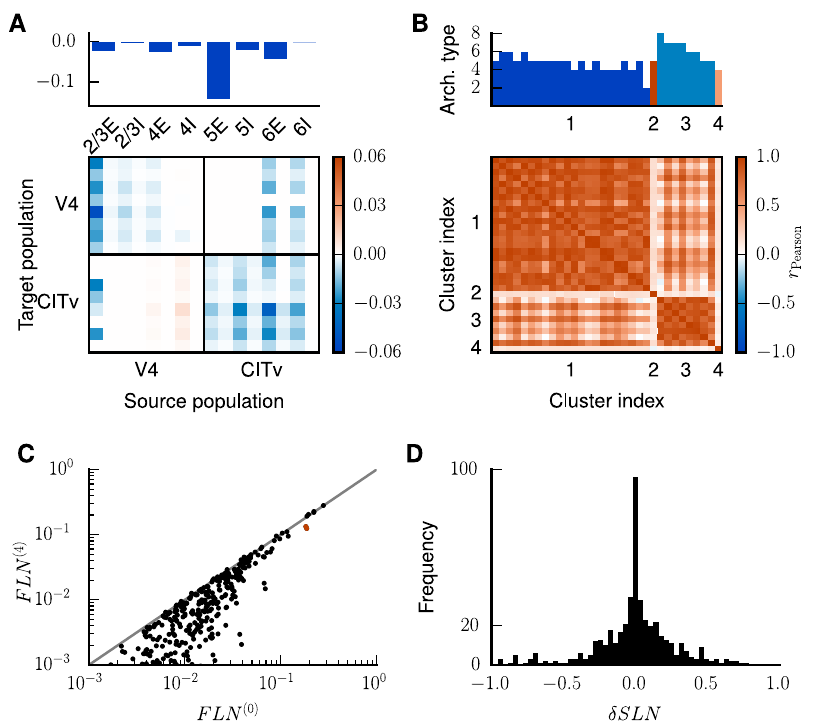
Fig 8. Analysis of changes in connectivity. A Top panel: relative changesin population-specific intrinsic P P d K ij = K ij i indegreessummed over target populations and averaged across areas, h . Bottom panel: A AA AA i i changesin the indegreeswithin and betweenexemplary areas V4 and CITv relative to the total indegreesof P = K ij the target populations,i.e., d K ij . Populationsorderedas in Fig 7C. B Pearson correlationcoefficient AA AA j of the changes of the internalindegrees d K ij between all pairs of the 32 areas. Areas ordered accordingto AA hierarchical clustering using a farthest point algorithm[31]. The heights of the bars on top of the matrix indicatethe architectural types of the areas (types 1 and 3 do not appearin the model)with color representing the respective clusters. C FLN of the modified connectivity after 4 iterationsversus the original FLN of the model. Only FLN > 10 (cid:0) 3 are shown for a better overview. The overlappingred dots representthe connections betweenareas 46 and FEF. Unity line shown in gray. D Histogram of the cumulativechangesin SLN over